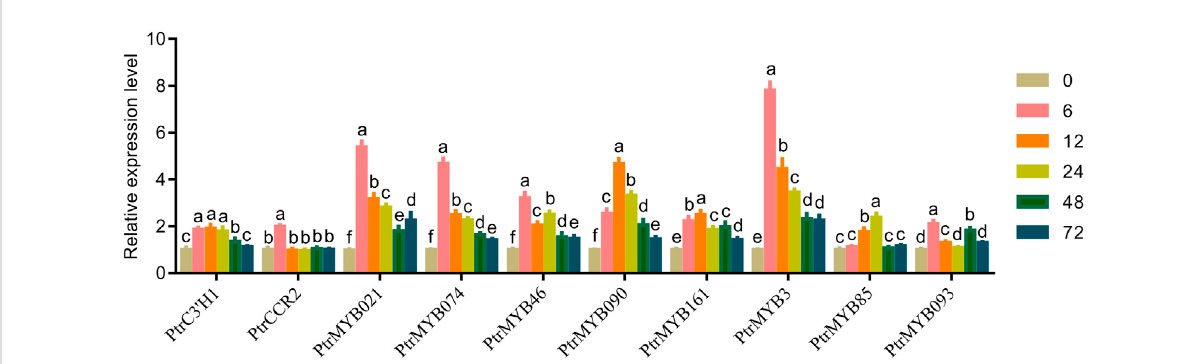
FIGURE 6 RT-qPCR analysis of lignin-related genes. RT-qPCR analysis of PtrC3 ’ H1 (Potri.006G033300), PtrCCR2 (Potri.003G181400), PtrMYB021 (Potri.009G053900) and PtrMYB074 (Potri.015G082700), PtrMYB103/46 (Potri.003G132000), PtrMYB090 (Potri.015G033600), PtrMYB161 (Potri.007G134500), PtrMYB3 (Potri.001G267300), PtrMYB125/85 (Potri.003G114100), PtrMYB093 (Potri.004G138000) of poplar stem with high temperaturetreatmentfor0, 6,12,24,48and72 h.Thesameletterof P 0.05 levelrepresentstheno difference whiledifferent P 0.05 level showed the imparity. The data showed as the mean ± SE was repeated three times.